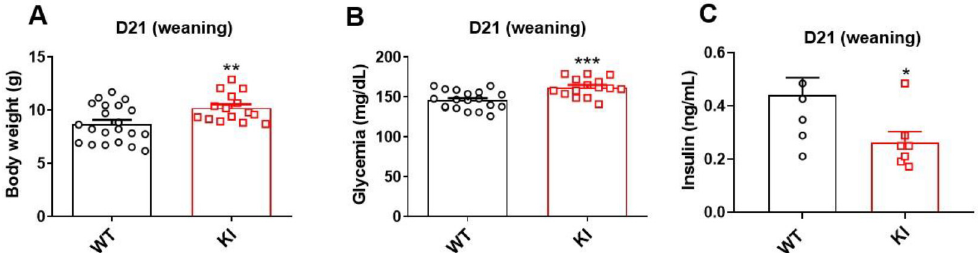
Figure 1. Characterization of KI S273A lineage at weaning (21 days old, D21), comparing with WT animals. ( A ) Body weight (g), ( B ) glycemia, and ( C ) plasma insulin levels in fed state. Data are represented as mean ± SEM. Statistical analysis was performed using non-parametric t -test. * p < 0.05, ** p < 0.01, and *** p < 0.001. n ≥ 5 per group.